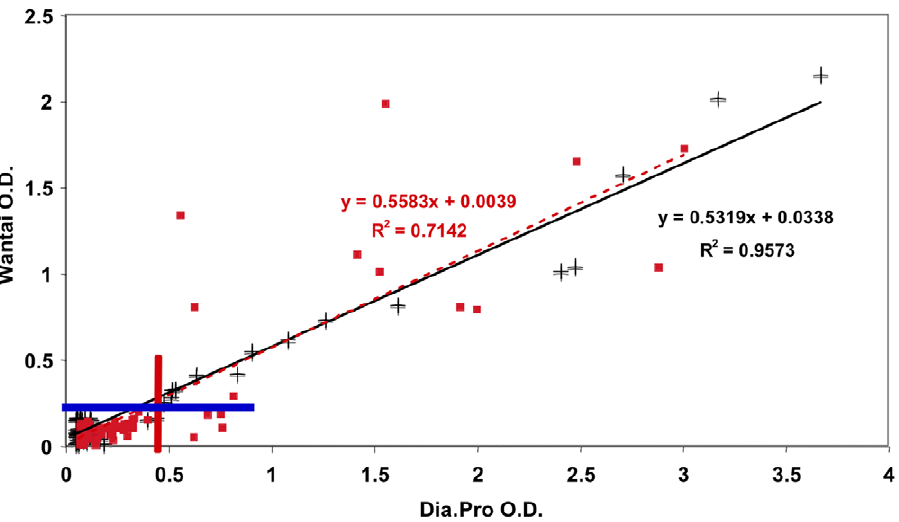
Figure 3. Evaluation of relation-ship between Wantai and Dia.Pro test results in positive samples. Crosses indicate blood donor samples and red squares samples from pregnant women. Linear correlations are significant within the two group but with significantly less dispersion of the blood donor samples than of the samples from pregnant women. The blue line indicates the cut-off level for the Wantai kit, and the red line the cut- off for the Dia.Pro kit.